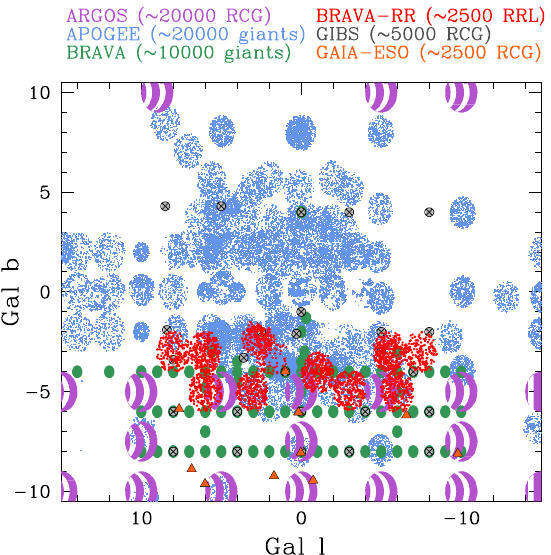
Figure 4. The spatial extent of recent spectroscopic surveys of bulge stars are shown—ARGOS (magenta), APOGEE (light blue), BRAVA (green), BRAVA-RR (red), GIBS (grey), and Gaia-ESO